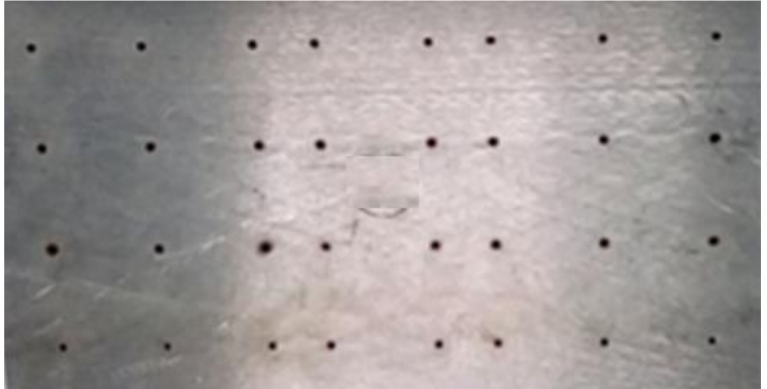
Figure 4. An array of microholes fabricated on SS 304 by micro spark-erosion drilling ( µ -SED) process using a rotating brass hollow tool electrode of 800 µ m diameter.